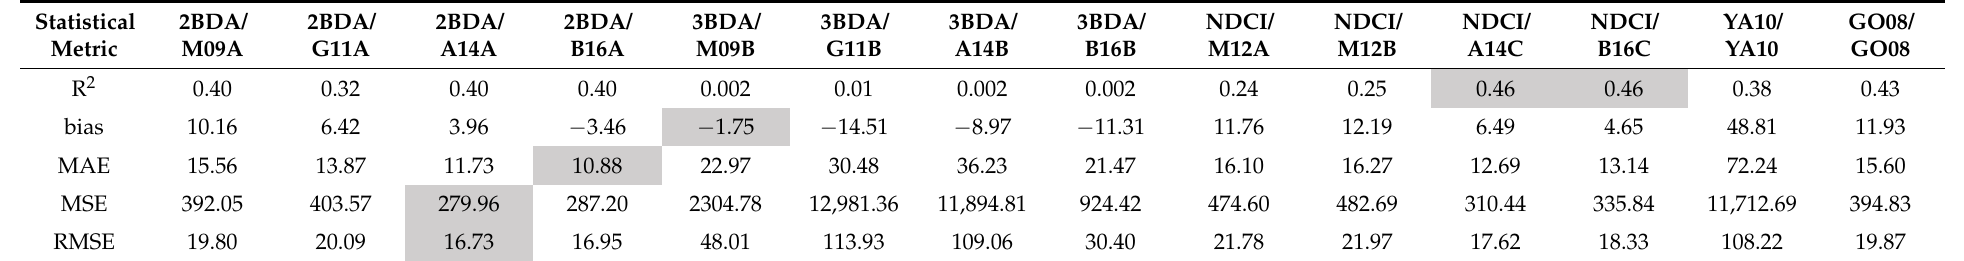
Table A2. Statistical metrics (R 2 , bias, MAE, MSE, RMSE) for different chl- a bio-optical algorithms from simulate Sentinel − 2/MSI spectral bands from proximal hyperspectral in situ data from all lakes. 2BDA with G10A calibration and 3BDA with G10B calibration did not produce results. Shaded cells indicate the best values of each metric. Statistical Metric